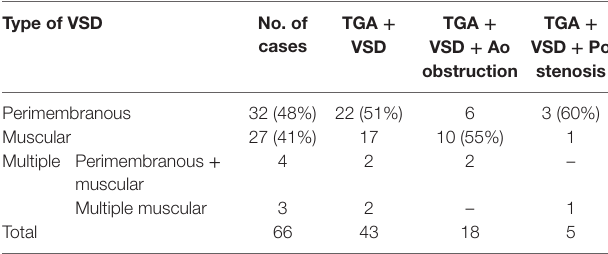
TaBle 4 | complete Tga: type of VsD.